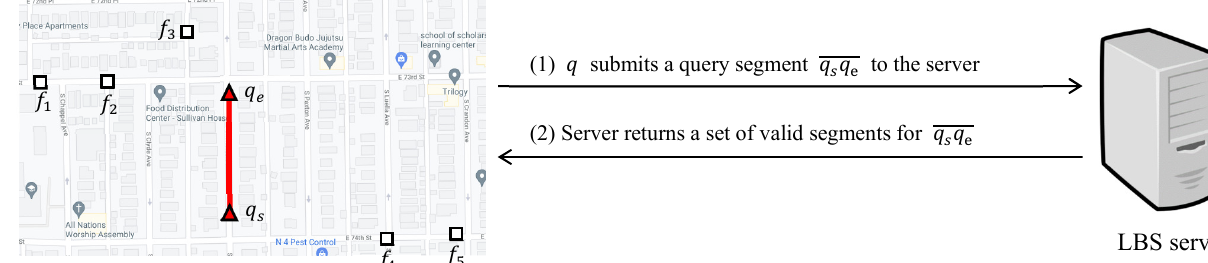
Figure 2. Interaction between the moving query point q and location-based service (LBS) server while q moves along q s q e